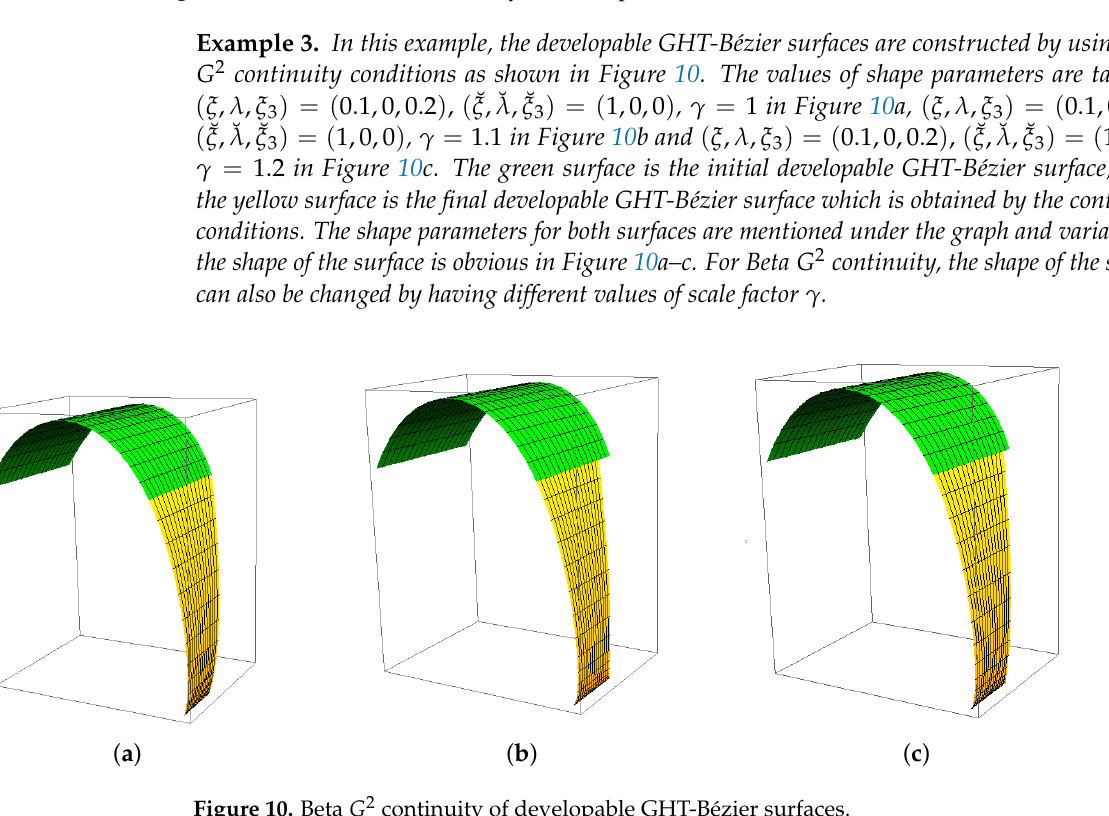
Figure 9. Farin-Boehm G 2 continuity of developable GHT-Bézier surfaces.